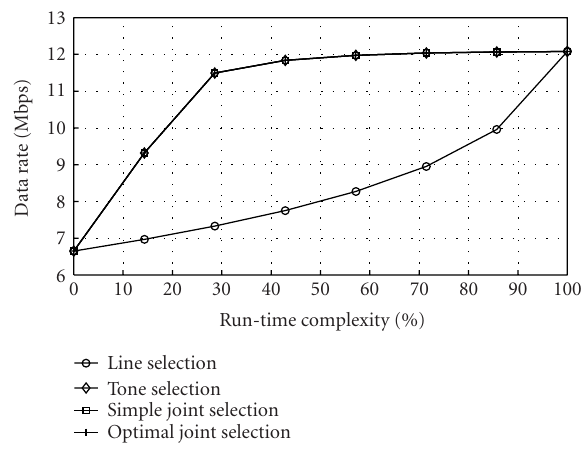
Figure 5: Data rate versus run-time complexity (equidistant